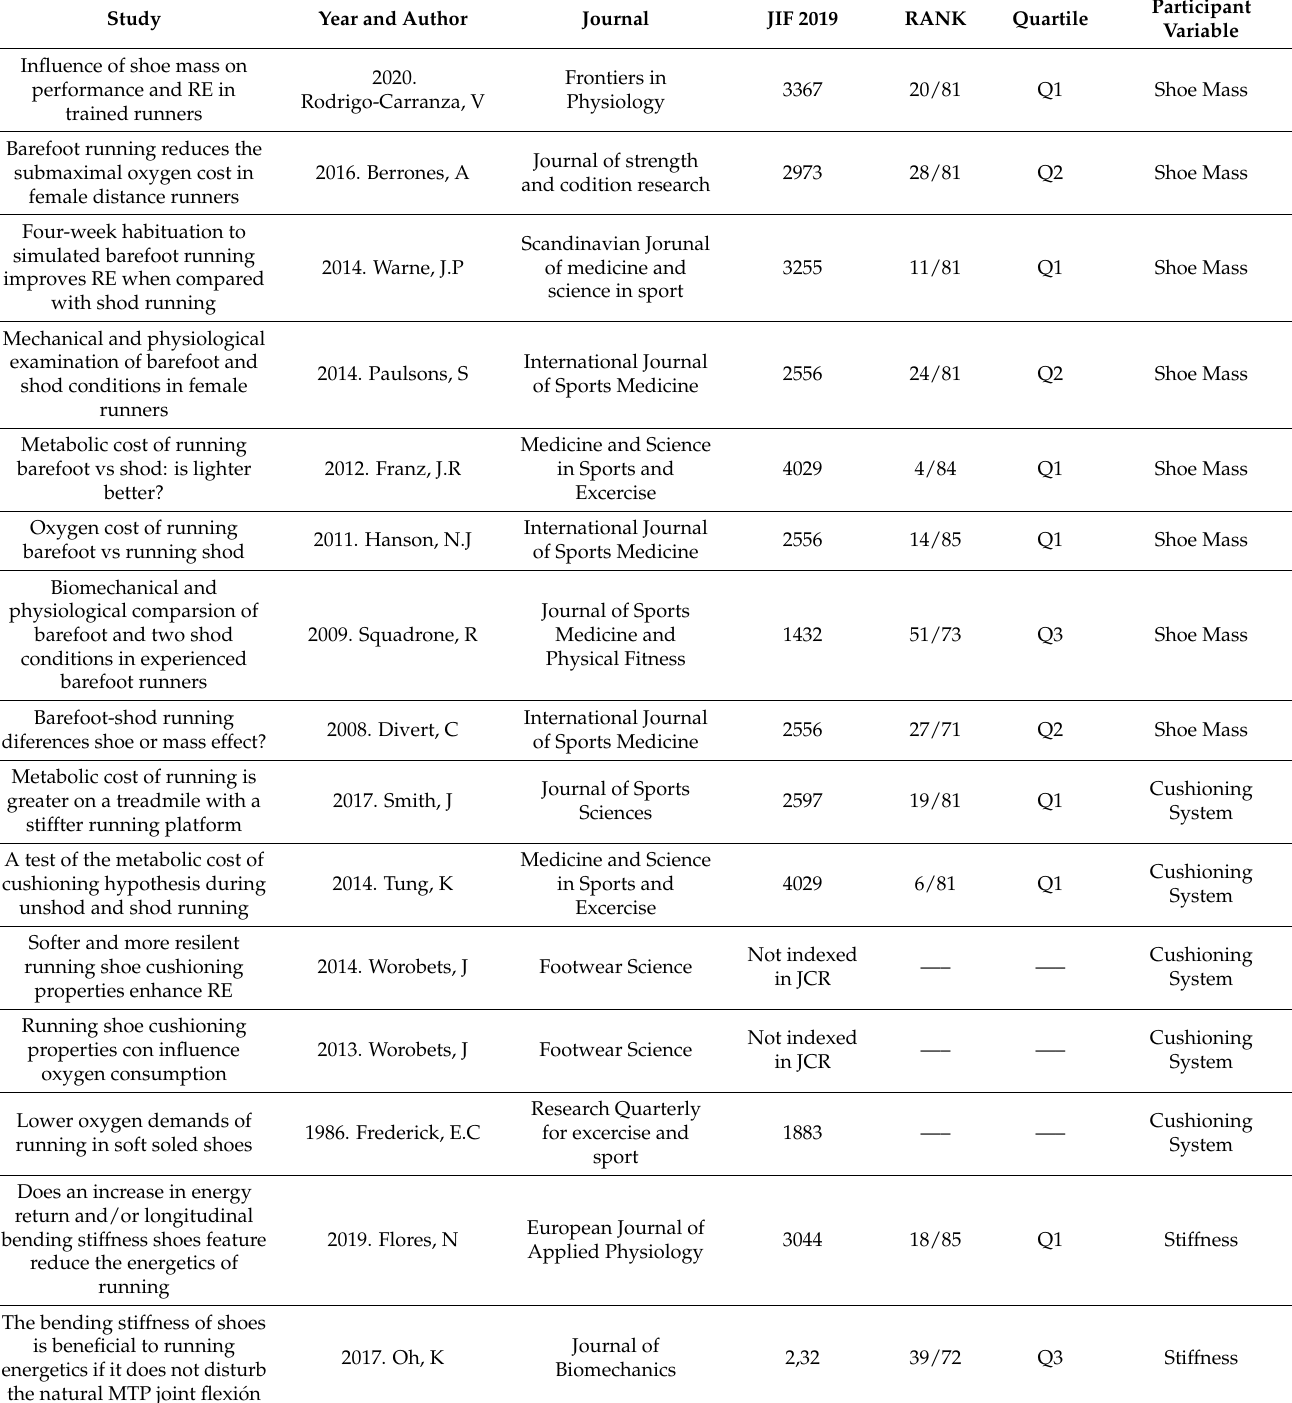
Table 8. Impact Factor. JIF. Journal Impact